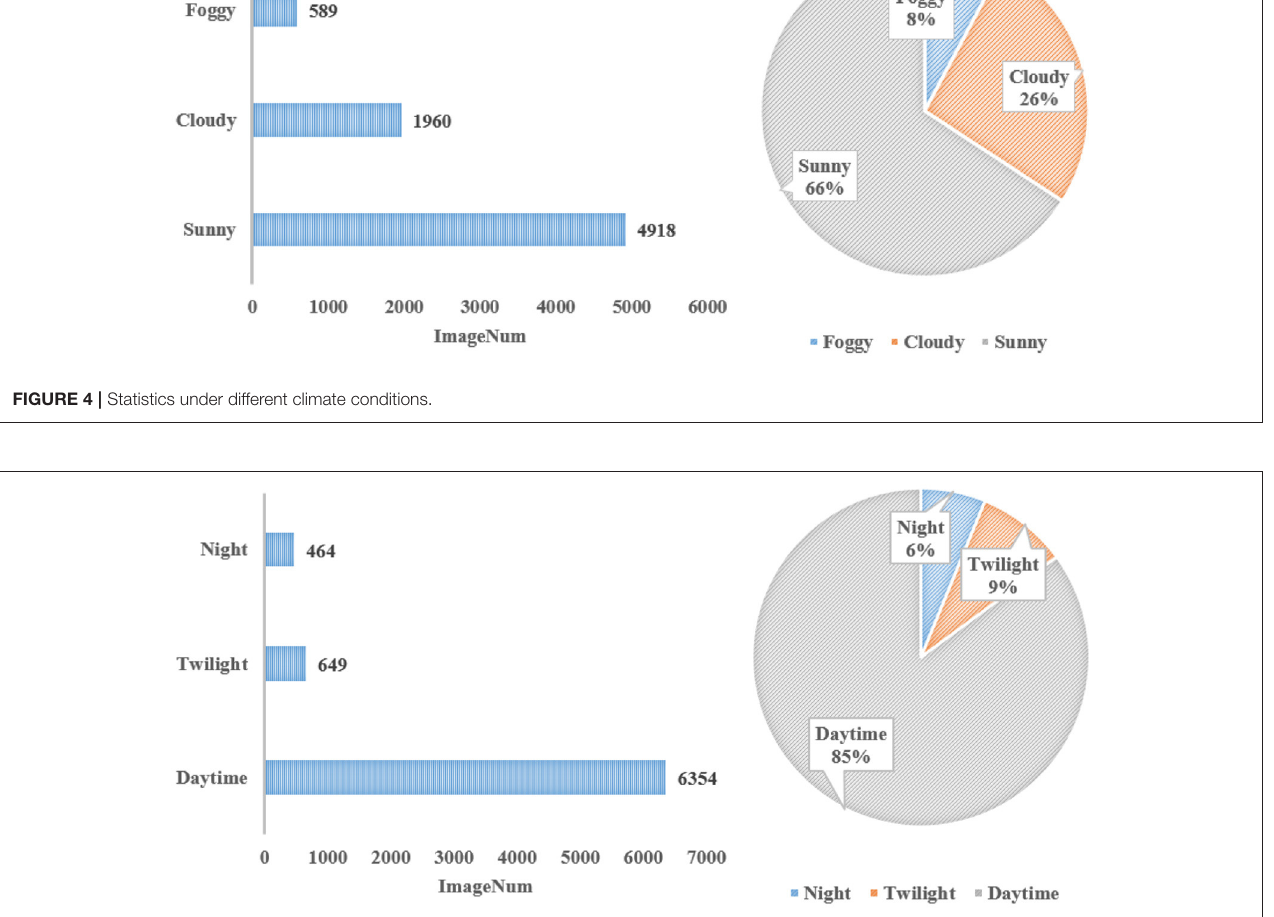
FIGURE 5 | Statistics under different shooting